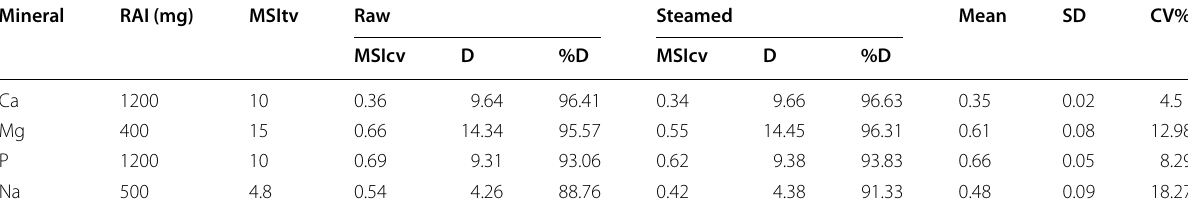
Table 4 Mineral safety index of raw and steamed flesh of African Mud Creeper, T. fuscatus var radula